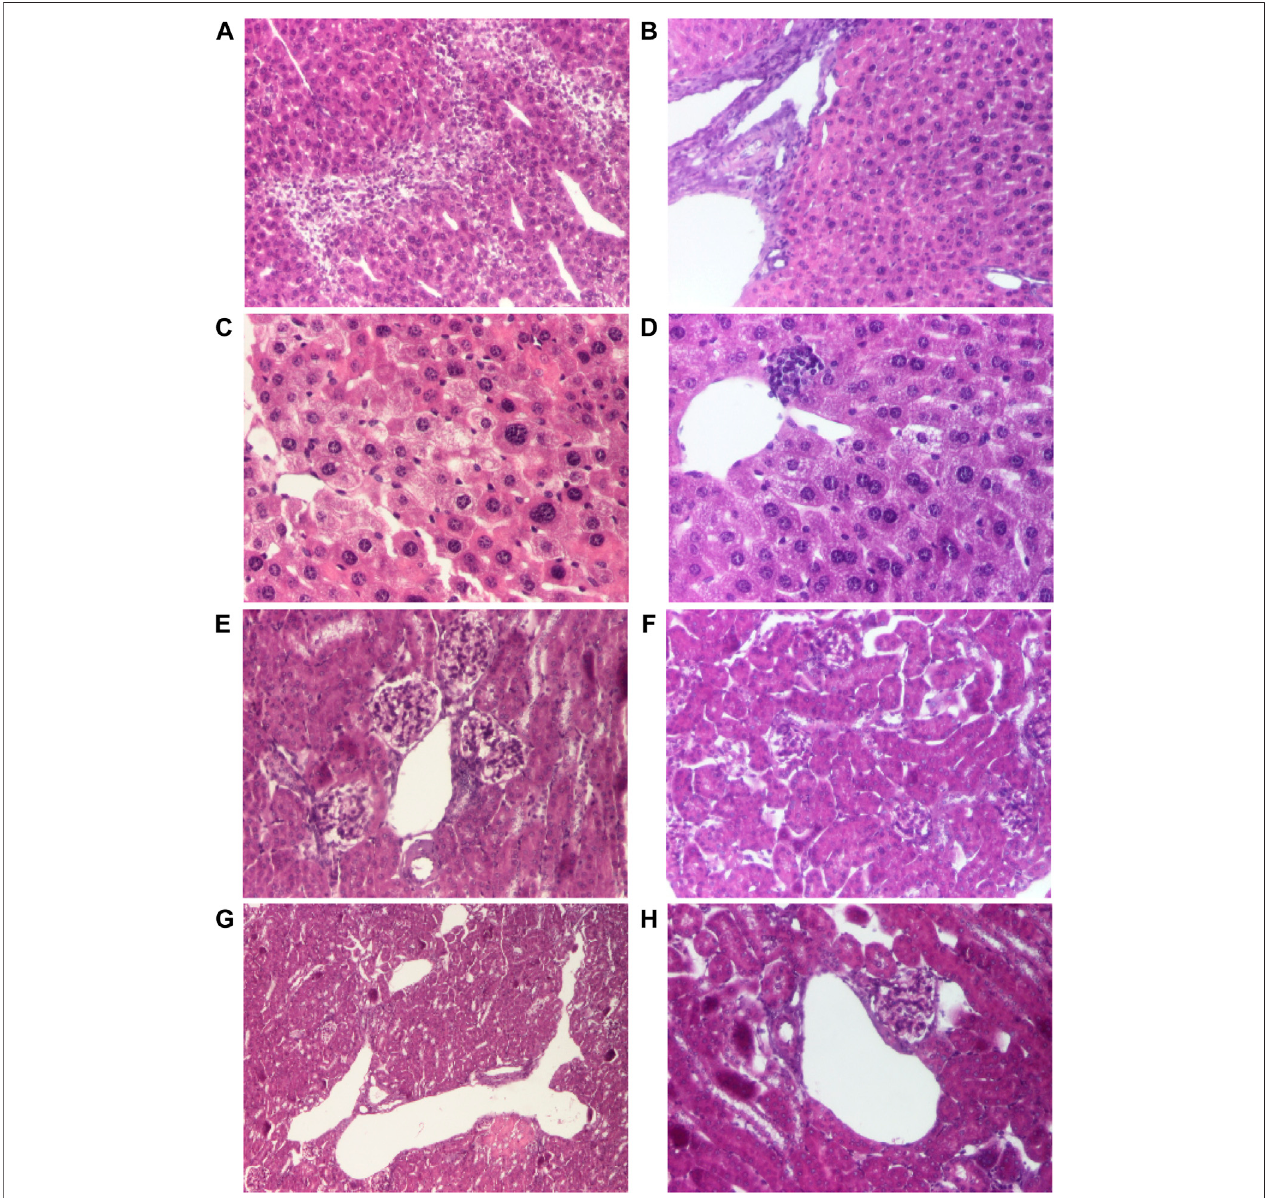
FIGURE 1| Histological changes ofthe main organs in the dead mice after doses of 690 mg/kg ofAMD (A, C, E, G) compared to 440 mg/kg of AMD (B, D, F, H) . RepresentativepicturesfromHEstainingsectionsoftheliverwithhepatitisaspect(hematoxylin-eosinHEstain, × 100) (A) ,liver – portalspace(hematoxylin-eosinHEstain, × 100) (B) , degeneration of hepatocytes (hematoxylin-eosin HE stain, × 200) (D) , hepatocytes (hematoxylin-eosin HE stain, × 200) (D) , renal cortex and arteriole (hematoxylin-eosin HE stain, × 200) (E) , renal cortex (hematoxylin-eosin HE stain, × 100) (F) , renal cortex and dilated renal veins (hematoxylin-eosin HE stain, × 40) (G) , renal cortex and dilated renal veins (hematoxylin-eosin HE stain, × 100) (H) .